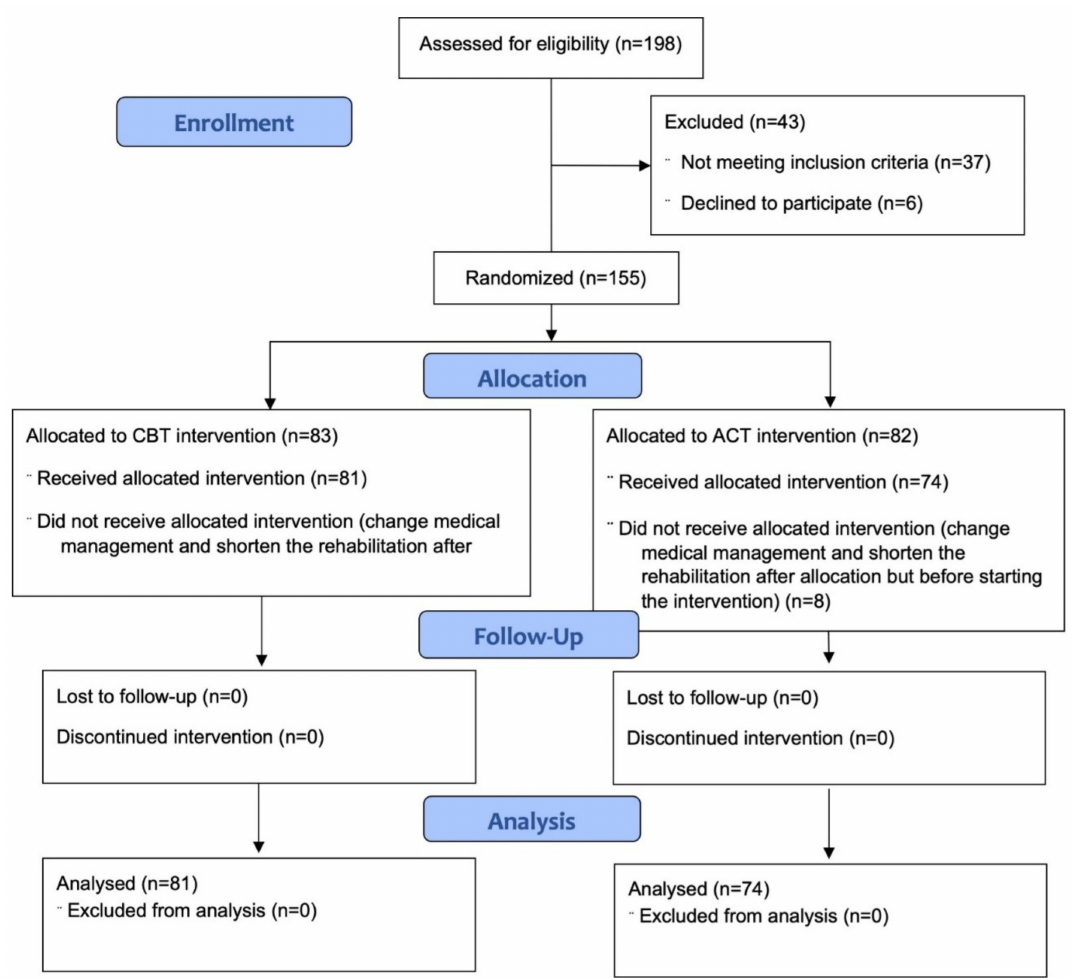
Figure 2. CONSORT diagram illustrating the enrollment procedures. Descriptive statistics of the baseline characteristics of the sample are shown in Table 2. There were no differences between the ACT and the CBT interventions regarding